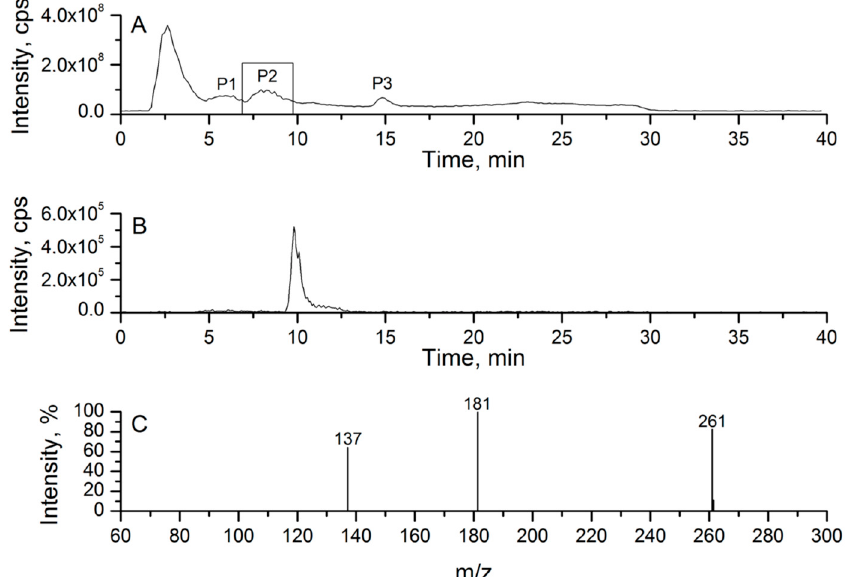
Figure 5. ( A ) TIC of mixture after synthesis of dihydrocaffeic acid sulfate; ( B ) chromatogram of dihydrocaffeic acid sulfate obtained after purification; ( C ) fragmentation spectra of dihydrocaffeic acid sulfate.